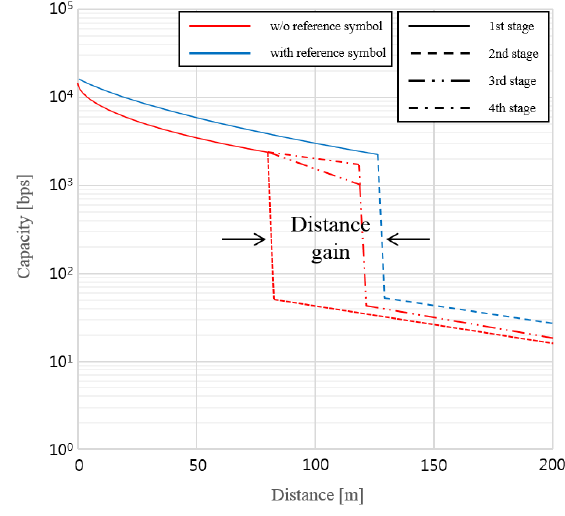
Figure 10. Numerical results of GCM based visual-MIMO (Channel capacity vs. Distance).